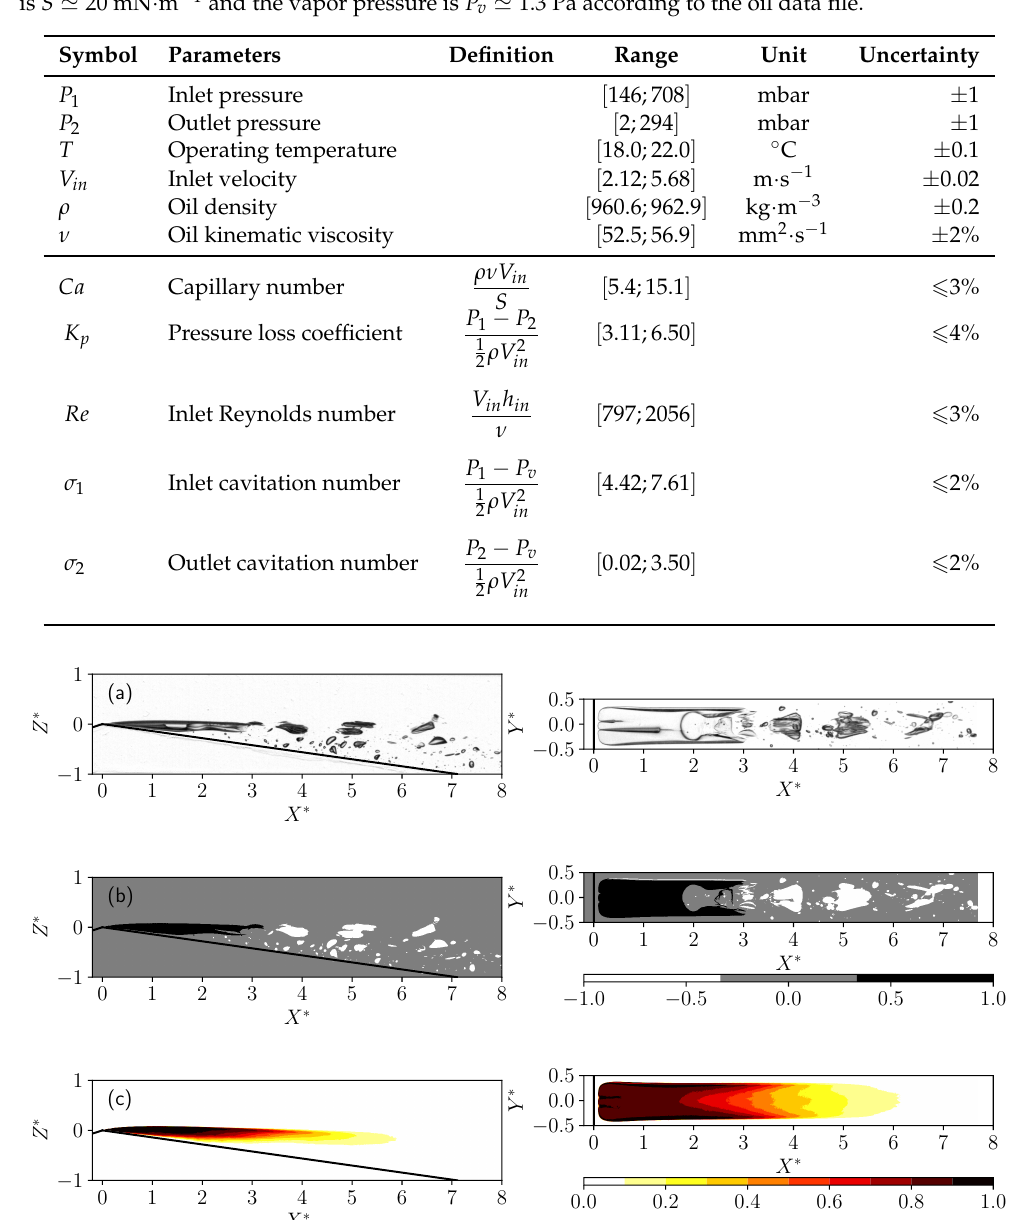
Table 1. Flow parameters, ranges and estimated uncertainties for silicone oil 47 V 50. The surface tension is S 20 mN m − 1 and the vapor pressure is P v (cid:39) ·